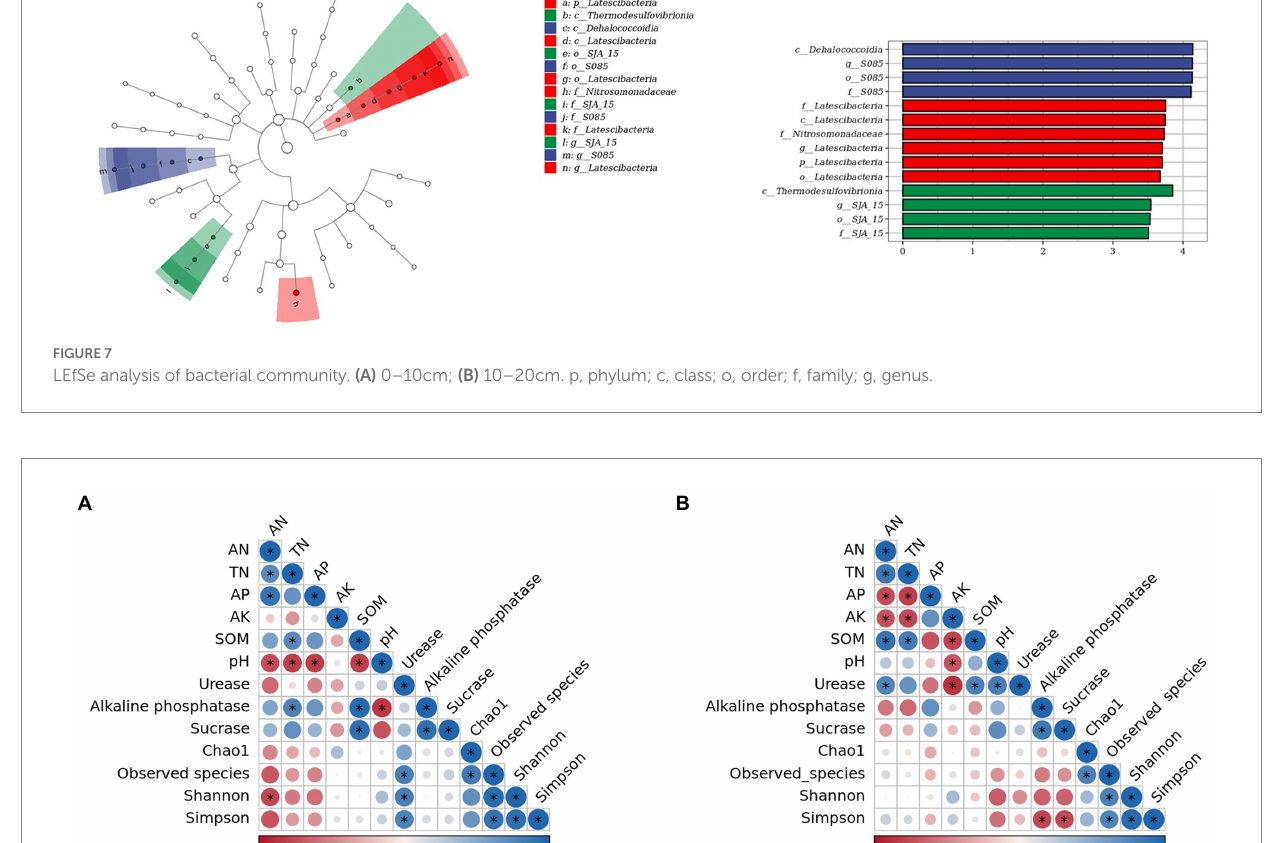
79.29 and 9.16% variations of the bacterial community, respectively. AK (r2 = 0.18, p = 0.39) had small influence on community composition. Acidobacteria was positively associated with AN, TN, AP, SOM, Alkaline phosphatase, and Sucrase (AN: r2 = 0.67, p = 0.01; TN: r2 = 0.55, p = 0.02; AP: r2 = 0.67, p = 0.00; SOM: r2 = 0.60, p = 0.01;